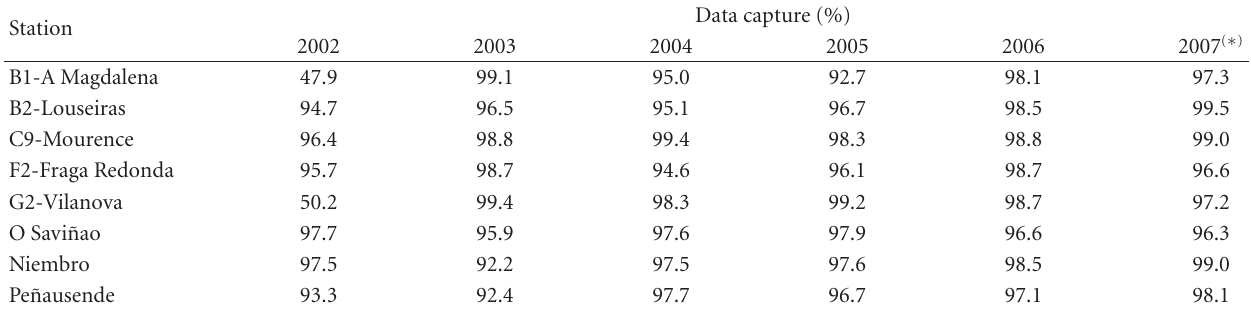
Table 3: Percentage of valid hourly O 3 measurements per year and station. Data of the the year 2007 are refered to its first eight months. Station